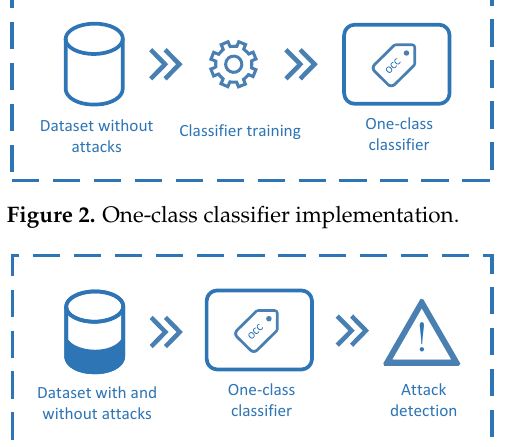
Figure 3. One-class classifier test stage.